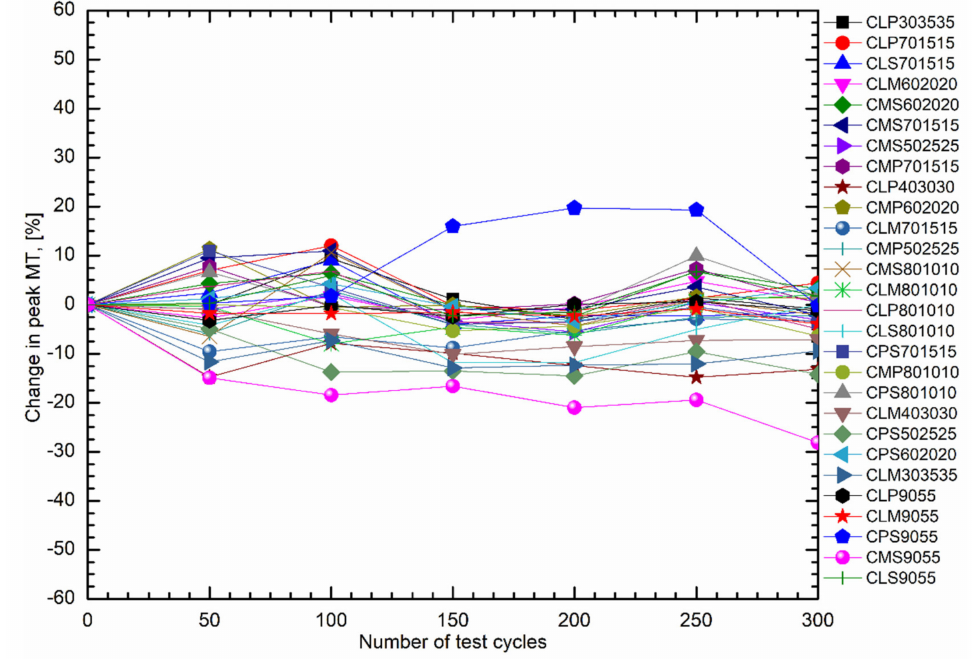
Figure 15. Change in melting peak with